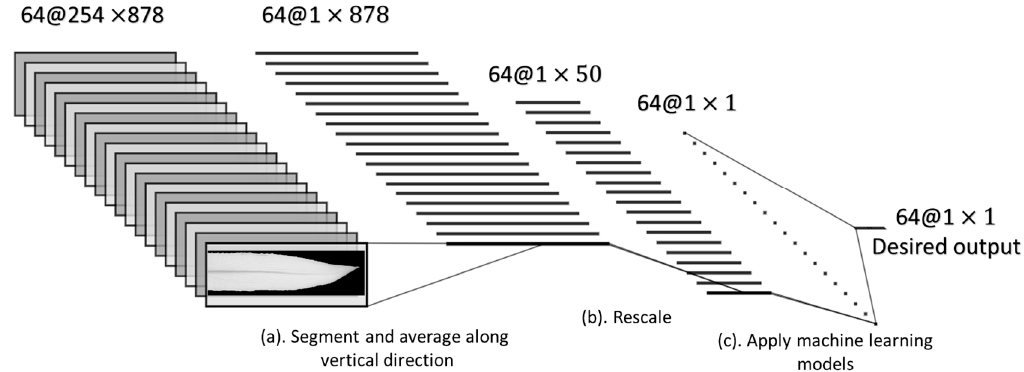
Figure 5. Overall schematic of the distribution feature analysis, from the raw NDVI image to the final prediction. It contains three major steps: ( a ) Segment the leaf and average along the vertical direction; ( b ) Rescale; ( c ) Model with the machine learning (ML) methods. Here, 64 @ 254 × 878 means that the original size of the NDVI image is 254 × 878, with 64 replicates for the model training.